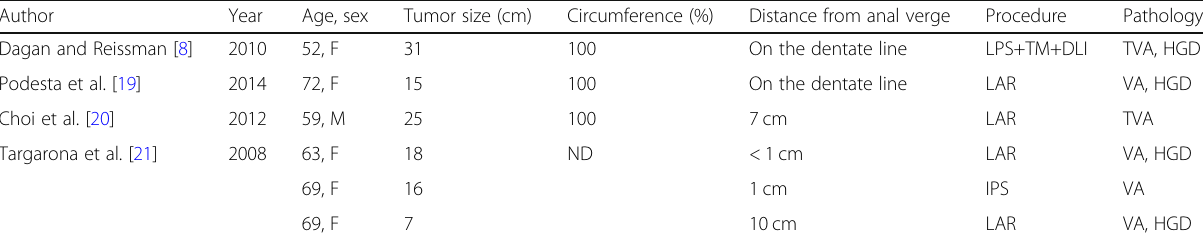
Table 1 Patients with McKittrick-Wheelock syndrome treated with laparoscopic low anterior resection and